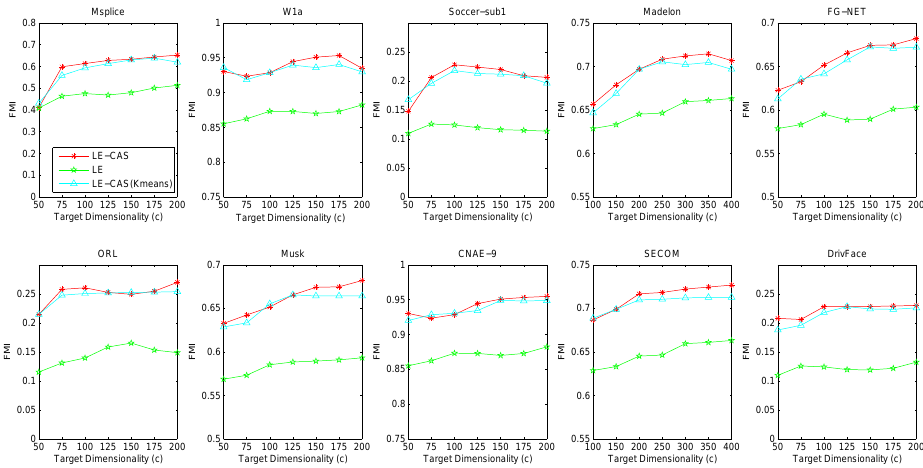
Figure 7. Results of FMI on ten datasets (Msplice, W1a, Soccer-sub1, Medelon, FG-NET, ORL, Musk, CNAE-9, SECOM, DrivFace) under different target dimensionalities ( c